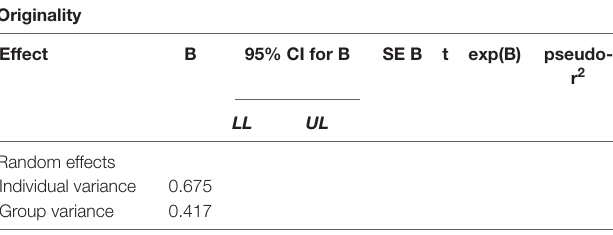
TABLE 1 | Summary of the “best” multivariate generalized linear mixed model predicting participants’ creative performance for the three measures: fluency, flexibility, and originality ( N =